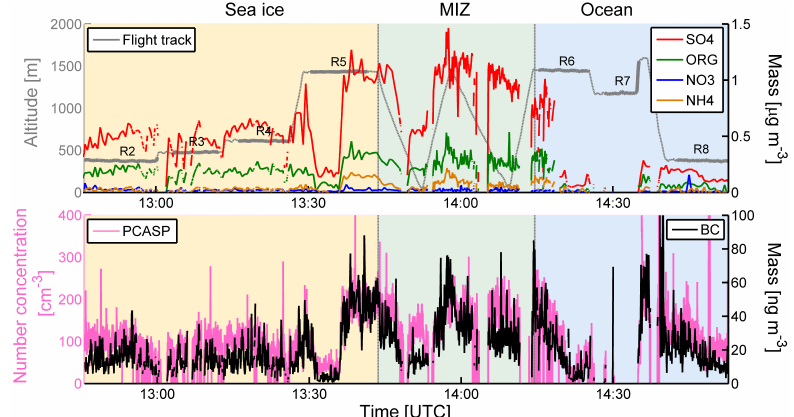
Figure 15. Time series of AMS and SP2 mass loading and PCASP number concentration. Top: flight track is shown in grey (with SLRs indicated in bold) with AMS species indicated by the legend in the top right. Bottom: aerosol number concentration and black carbon mass loading from the PCASP (pink) and SP2 (black) respectively. Only out of cloud (CDP LWC ≤ 0.01gm − 3 ) data are included.